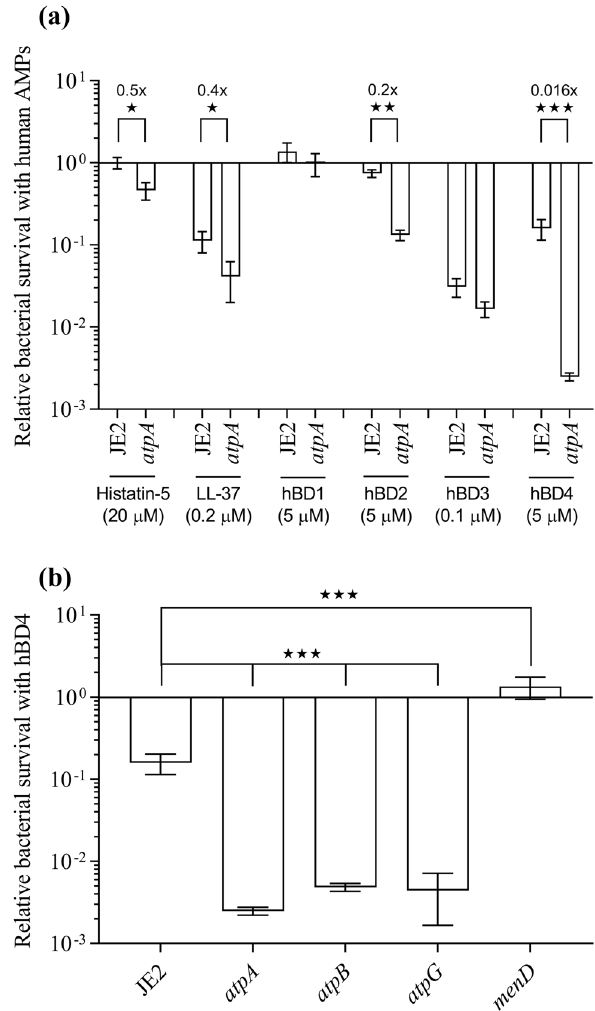
Figure 1. ATP synthase mutants are more susceptible to specific human AMPs than the WT. ( a ) The susceptibilities to the different AMPs assayed are presented as the relative survival following 2 h exposure at the indicated AMP concentrations for JE2 (WT) and atpA mutant. ( b ) Survival of ATP synthase mutants ( atpA , atpB and atpG ) and menD mutant following 2 h exposure to hBD4 (5 µM). Each survival value provided is the mean ± SEM derived from at least three independent